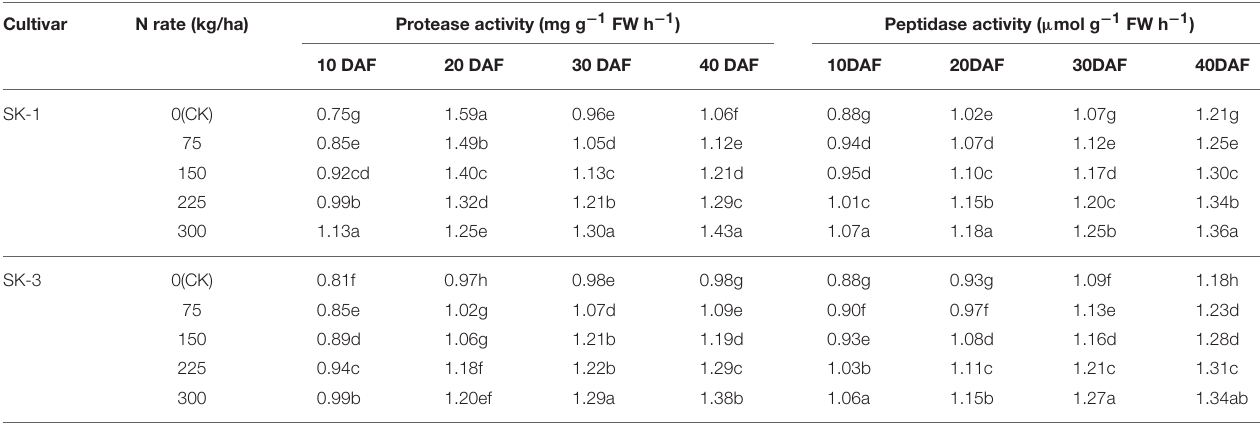
TABLE 9 | The effect of the nitrogen level on the boll shell protease and peptidase activities of the two Bt cotton cultivars in 2015. Cultivar